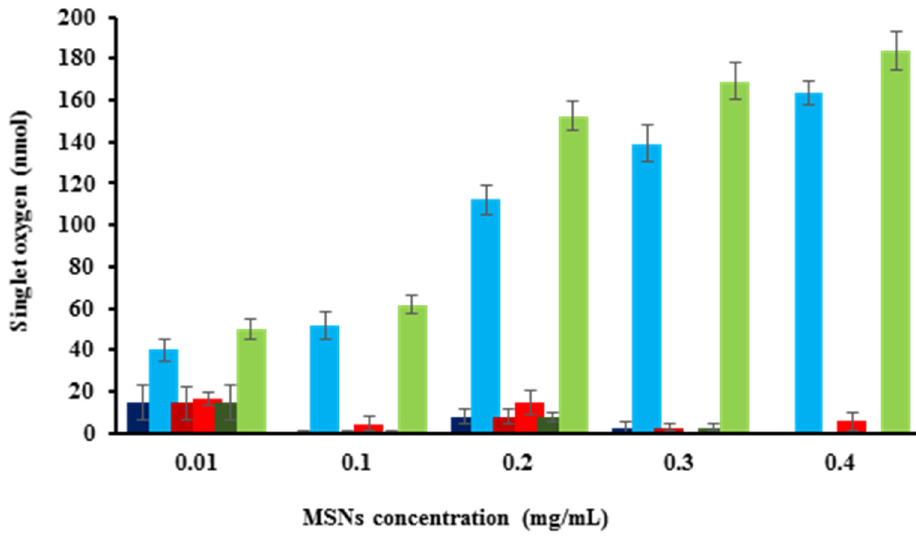
Figure 4. Singlet oxygen generation, without irradiation, by AlClPc-MSNs ( dark blue ), cisplatin-MSNs ( dark red ) and AlClPc/cisplatin-MSNs ( dark green ); and after irradiation, with red light, by AlClPc-MSNs ( light blue ), cisplatin-MSNs ( light red ), and AlClPc/cisplatin-MSNs ( light green